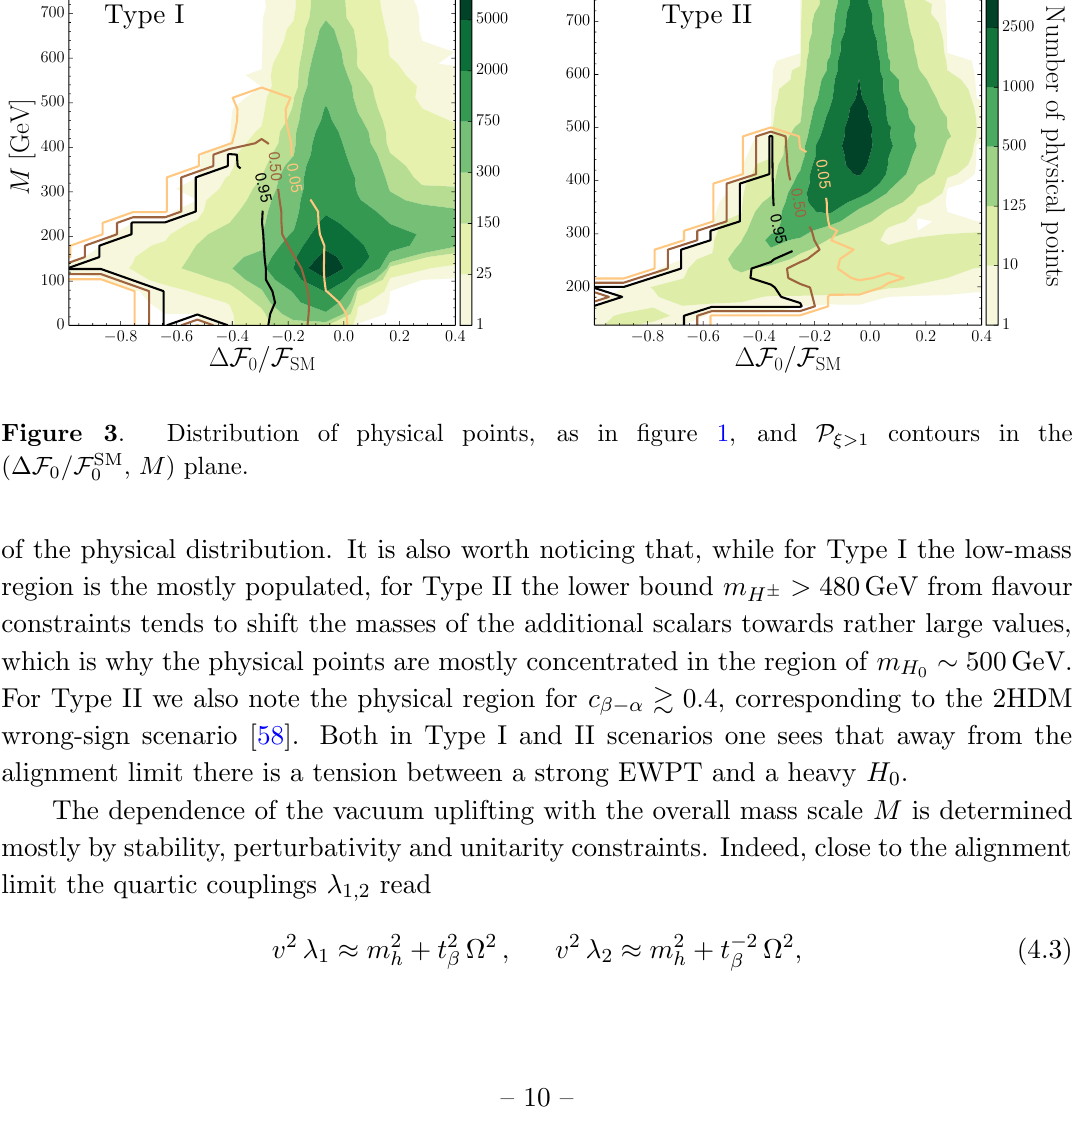
Figure 2 . Distribution of physical points, as in (cid:12)gure 1, and plane. As H 0 gets heavier, a strong (cid:12)rst order EWPT increasingly favours alignment. In Type II the wrong-sign scenario, albeit less populated, can also lead to a strong EWPT.